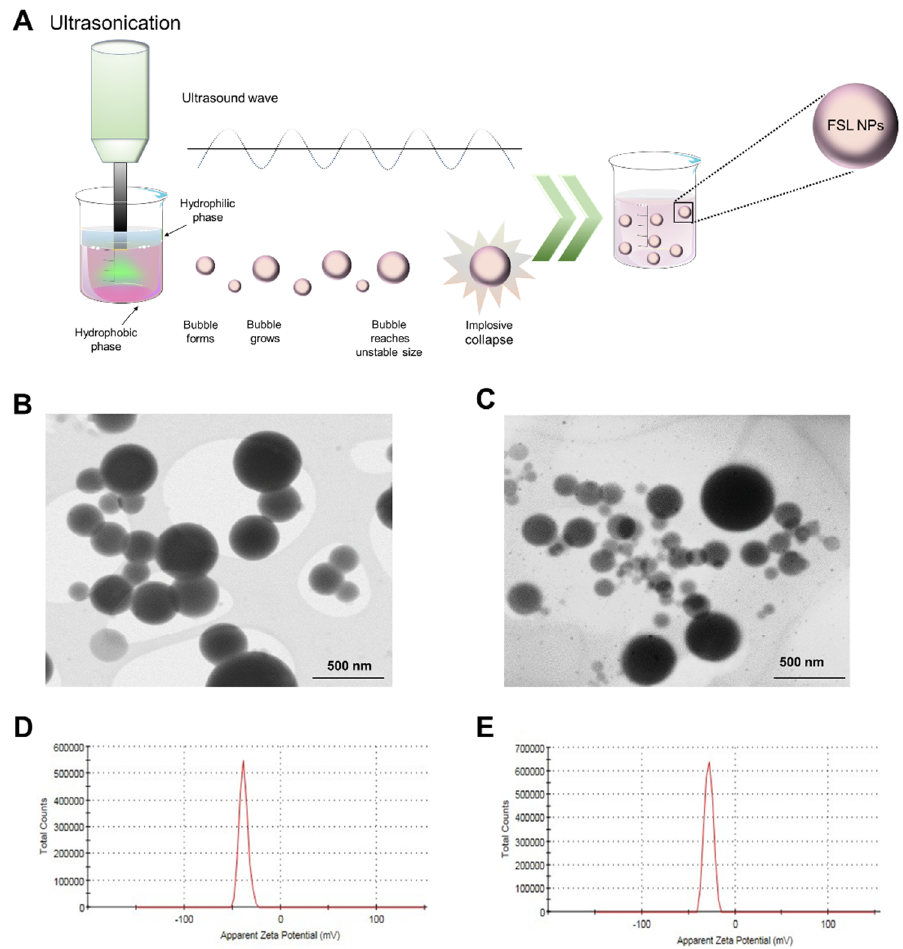
Figure 1. NP preparation and characterization. ( A ) Schematic representation of FSL NP synthesis using US. STEM images with magnification 120,000× of ( B ) empty NPs and ( C ) FSL NPs. Zeta−potential distribution graph showing negative zeta-potential values for ( D ) empty and ( E ) FSL NPs.